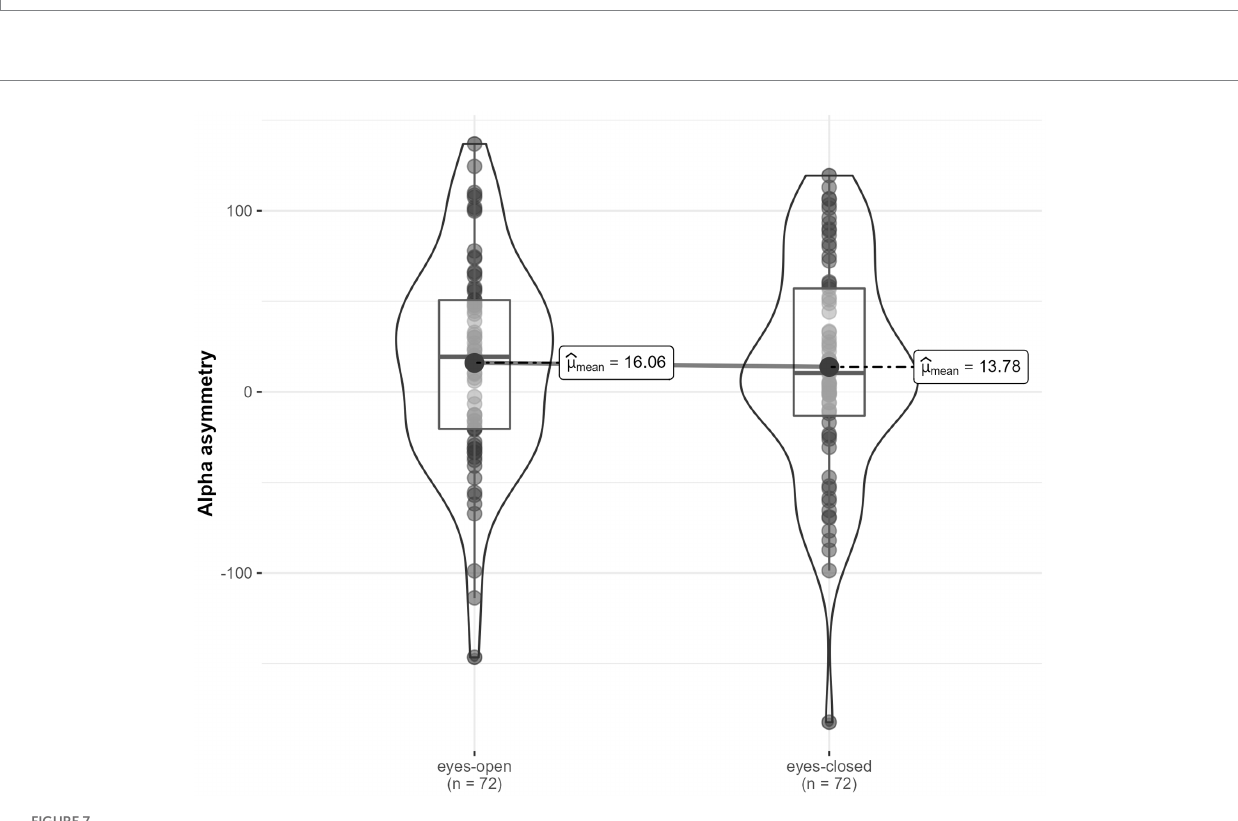
FIGURE 7 Alpha asymmetry in two conditions (eyes-open, eyes-closed), across